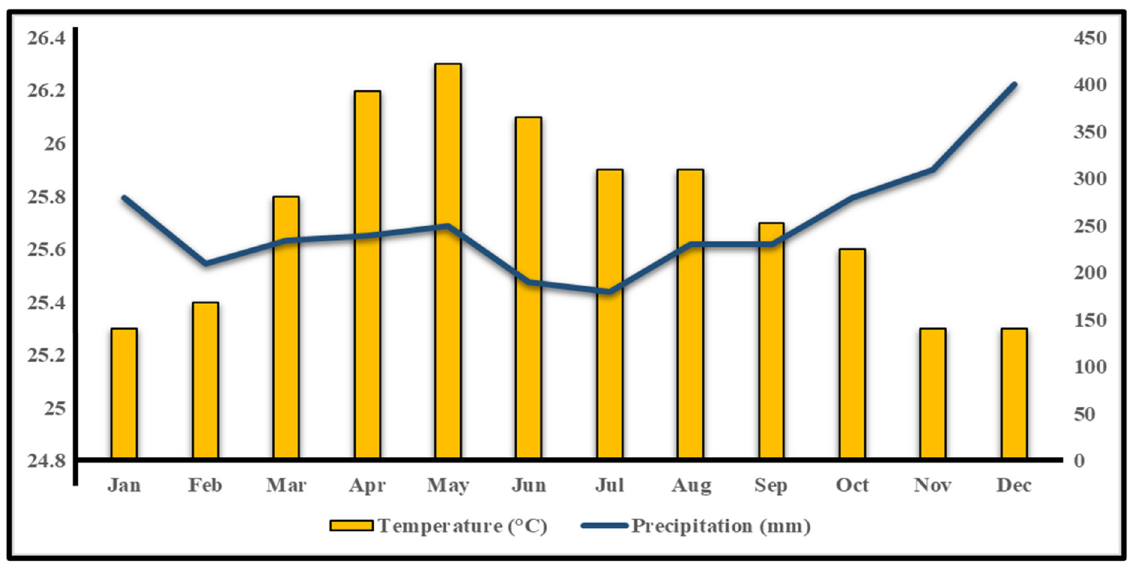
Figure 3. Climate average of the study site. (A) Average precipitation (mm) and mean temperature (°C) of the study site (Puchong) between 2010 and 2020 (Accessed on 23 April 2021, World Weather Online https://www.worldweatheronline.com/).